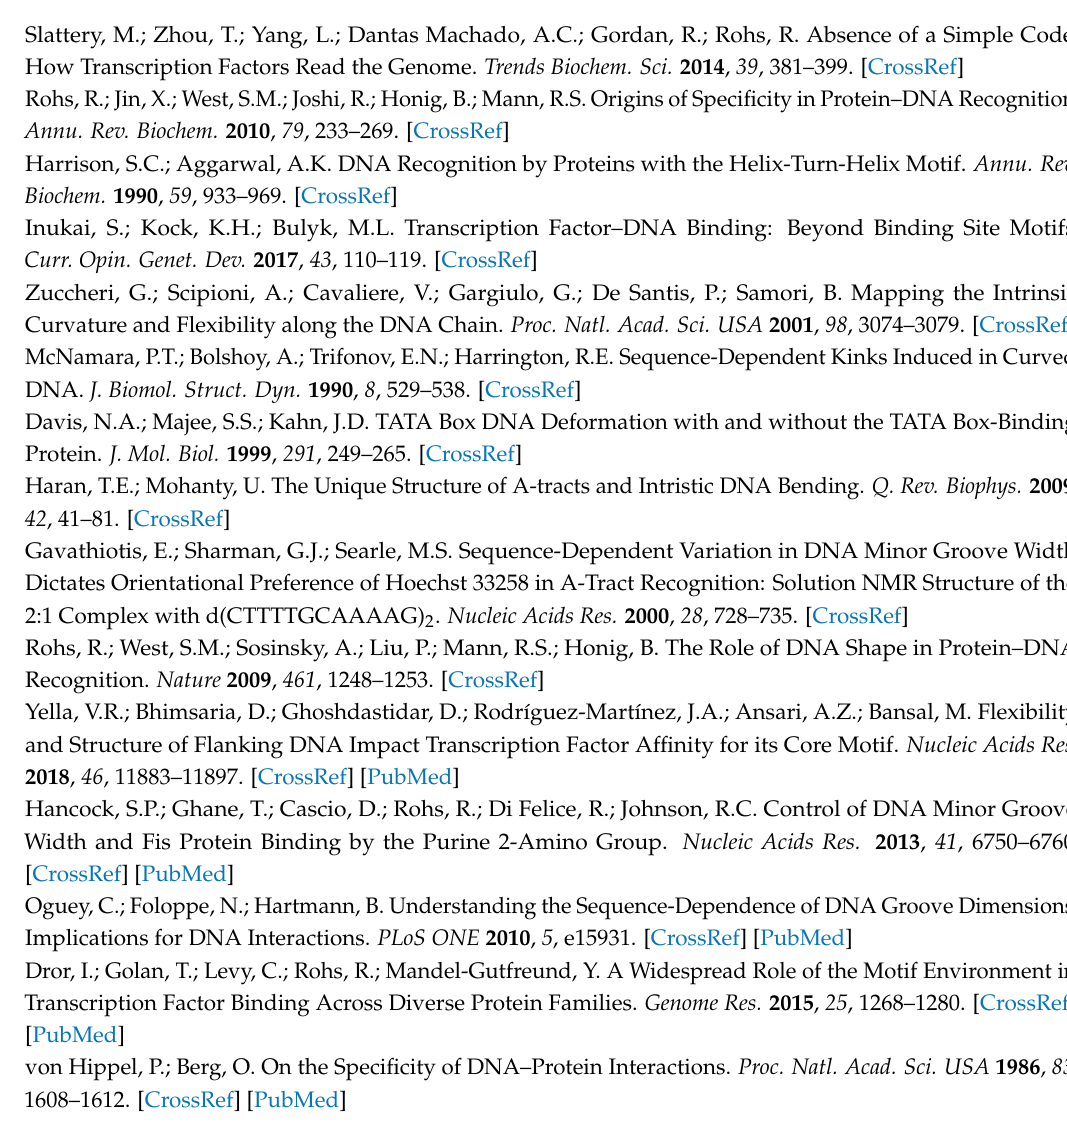
s1: Figure S1: ( a ) Portion of amino acid residues that were assigned a hydrogen bonding interaction using the SNAP program. ( b ) Portion of amino acid residues assigned a van der Waals interaction. Table S1: Results of the one-sided Mann–Whitney U test for datasets DS1 and DS2. Figure S2: DNA-contacting amino acid preferences for dinucleotide step sequences. Table S2: Populations of hydrogen bonding interactions between the main chain atoms of amino acids and various moieties of the nucleotides in the three DNA minor groove width categories. Figure S3: DNA-contacting amino acid preferences for dinucleotide step sequence